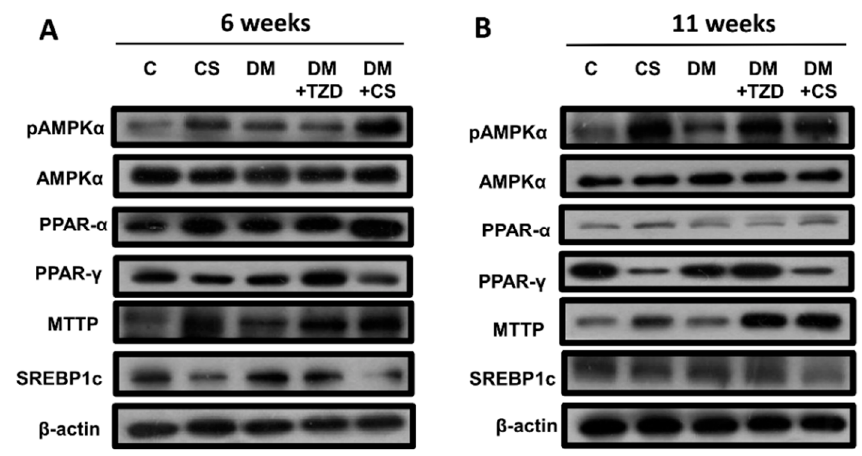
Figure 1. Effects of chitosan on metabolic signaling protein expression in the liver of diabetic rats with different feeding durations. ( A ) 6-week feeding duration; ( B ) 11-week feeding duration. The protein expressions for phosphorylated AMPK, AMPK, PPAR- α , PPAR- γ , MTTP, SREBP1c, and β -actin (internal control) were determined by Western blot analysis. The quantification is shown in Figure 2.